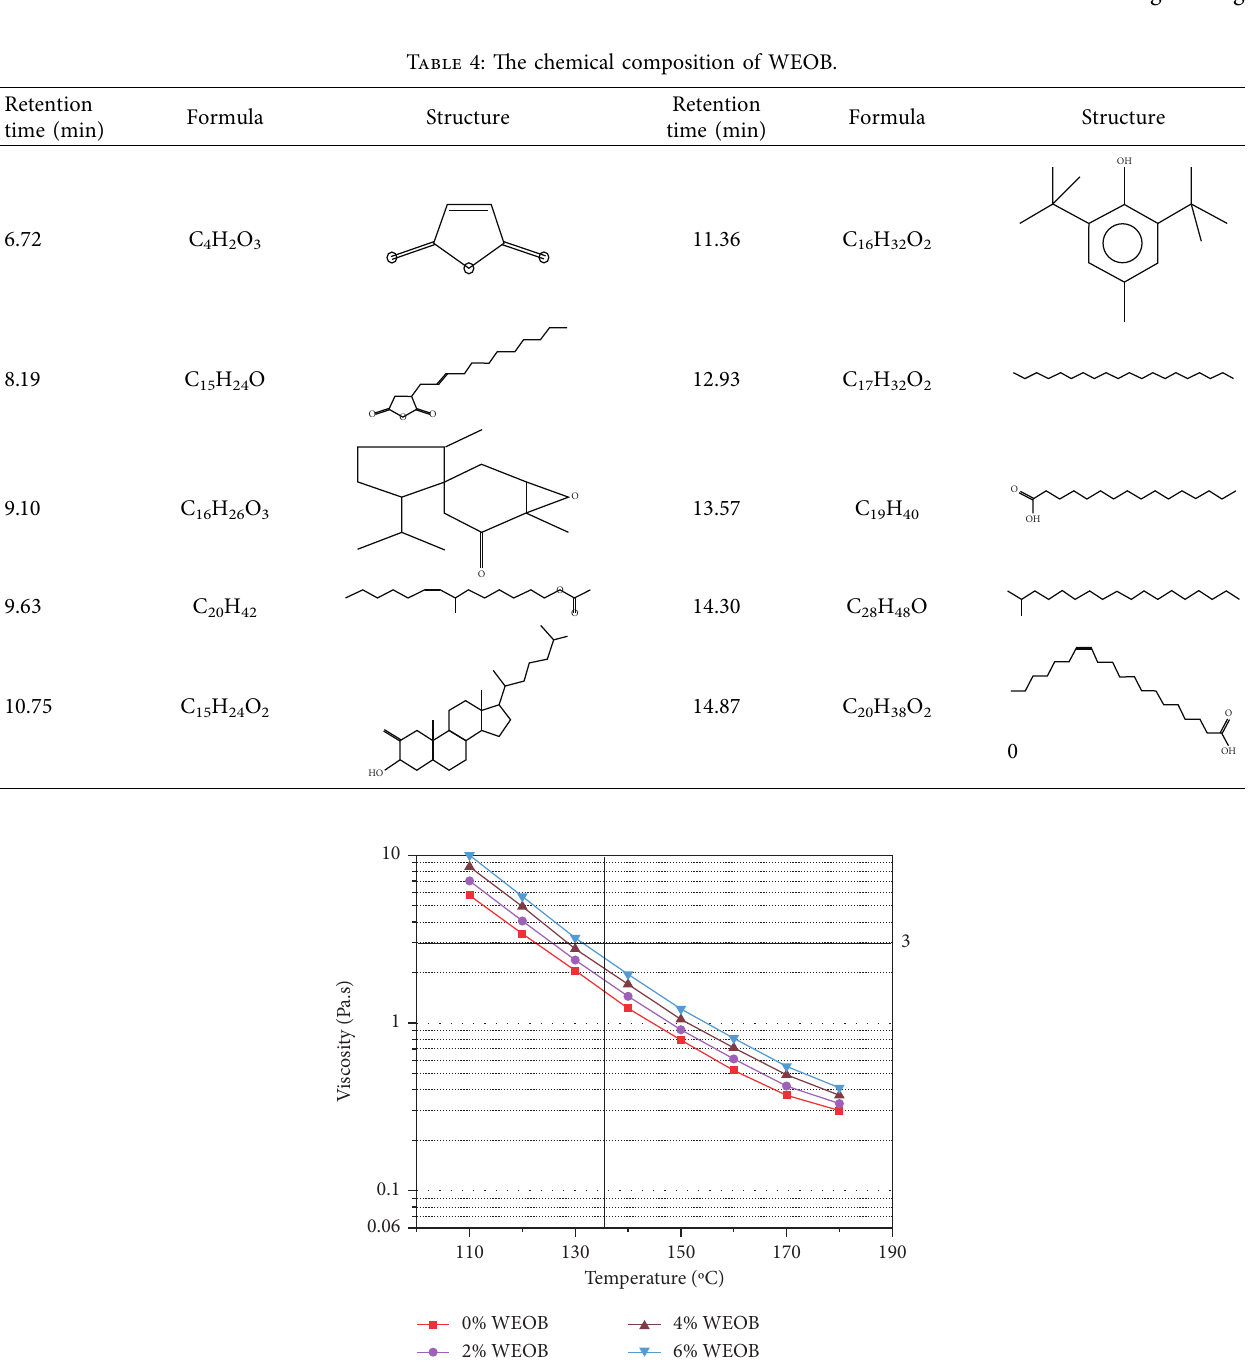
Figure 6: Viscosity results of the WEOB/SBS-modified